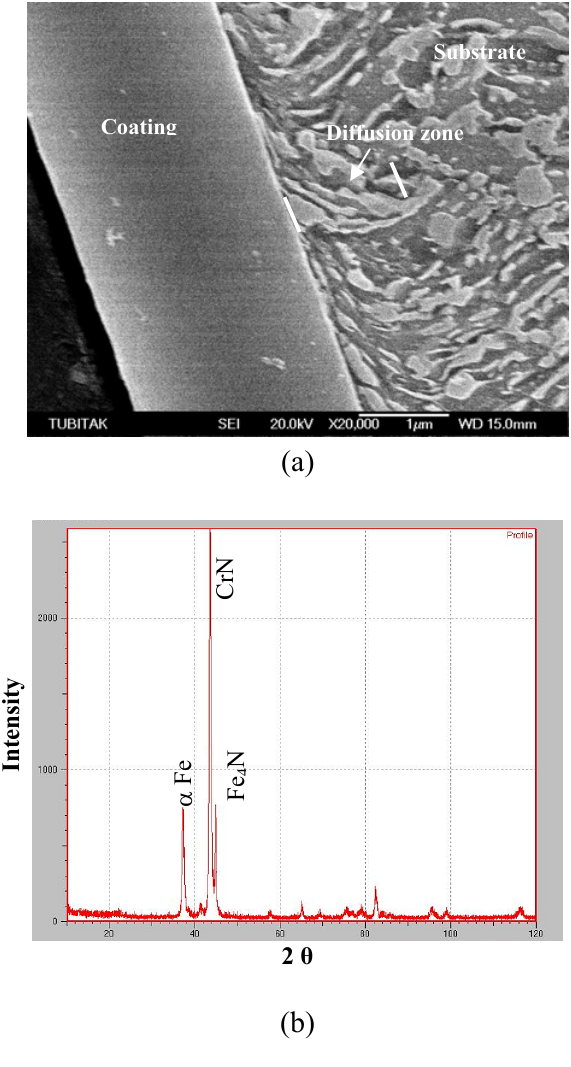
Figure 11 . CrN-coated specimen: (a) SEM micrograph showing the microstructure across the cross-section and (b) XRD